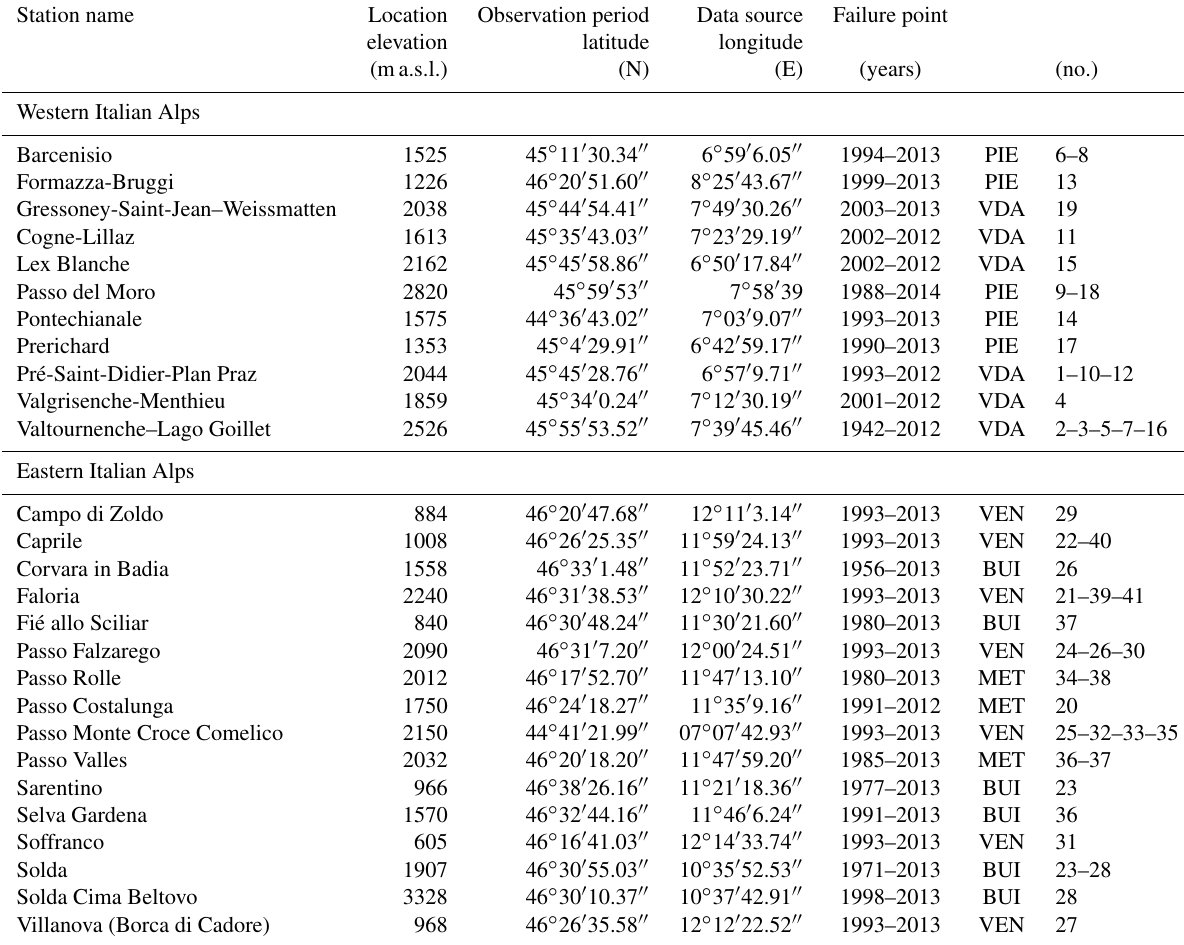
Table 2. Main characteristics of the meteorological stations considered in this study. Only meteorological stations representing the best compromise between the requirements mentioned in Sect. 3.2 (i.e. covering the failure date, long-term dataset, low distance from the failure area) are displayed. No.: failure point numbers (from Table 1) associated with the meteorological stations; variables recorded at the stations: T (temperature), (cid:49)T (temperature variation between the day of the failure and the days before), and R (precipitation). Data source: ARPA Piemonte, 2014 (PIE); ARPA Veneto, 2014 (VEN); Centro Funzionale – Regione Autonoma Valle d’Aosta, 2014 (VDA); Ufficio